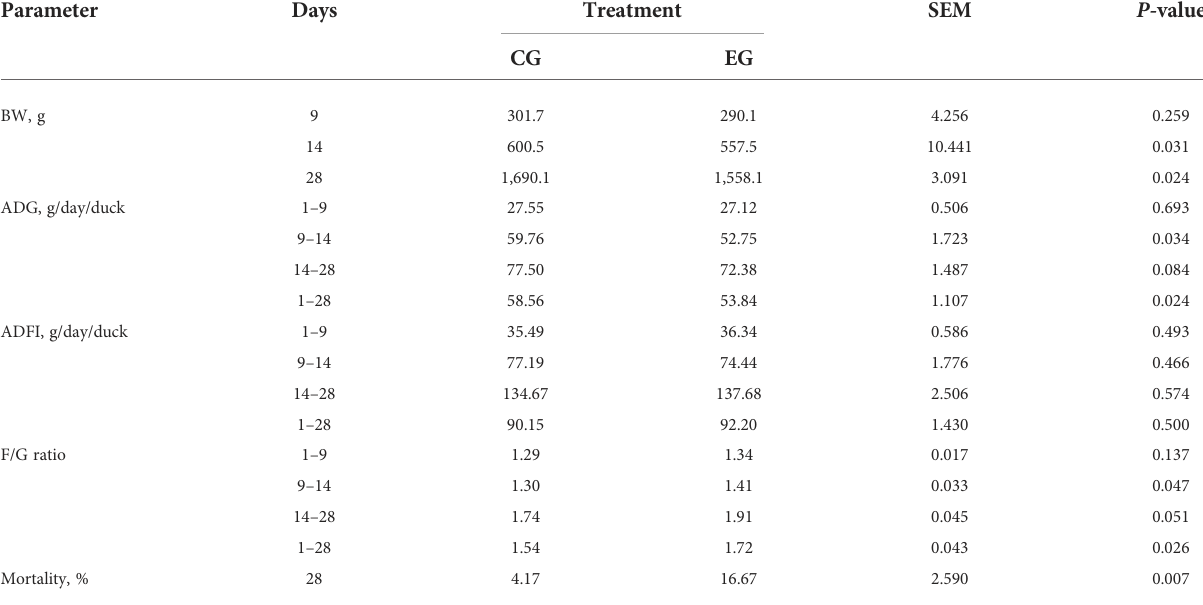
TABLE 2 Effect of the Escherichia coli challenge on the growth performance of ducks ( n = 6).